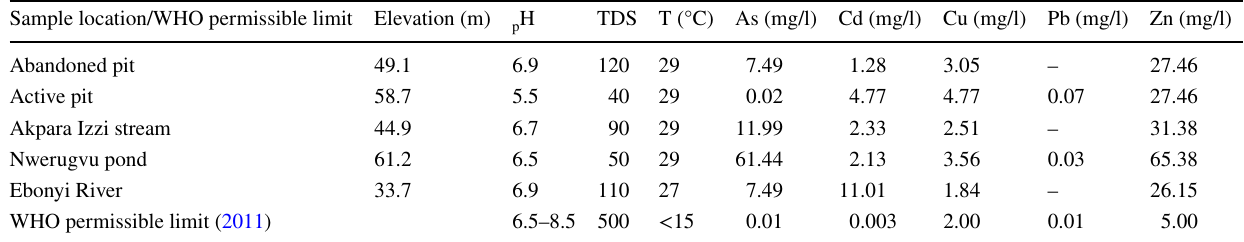
Table 1 Mean values of heavy metal concentration (mg/l) of As, Cd, Cu, Pb and Zn in surface water/WHO permissible limits